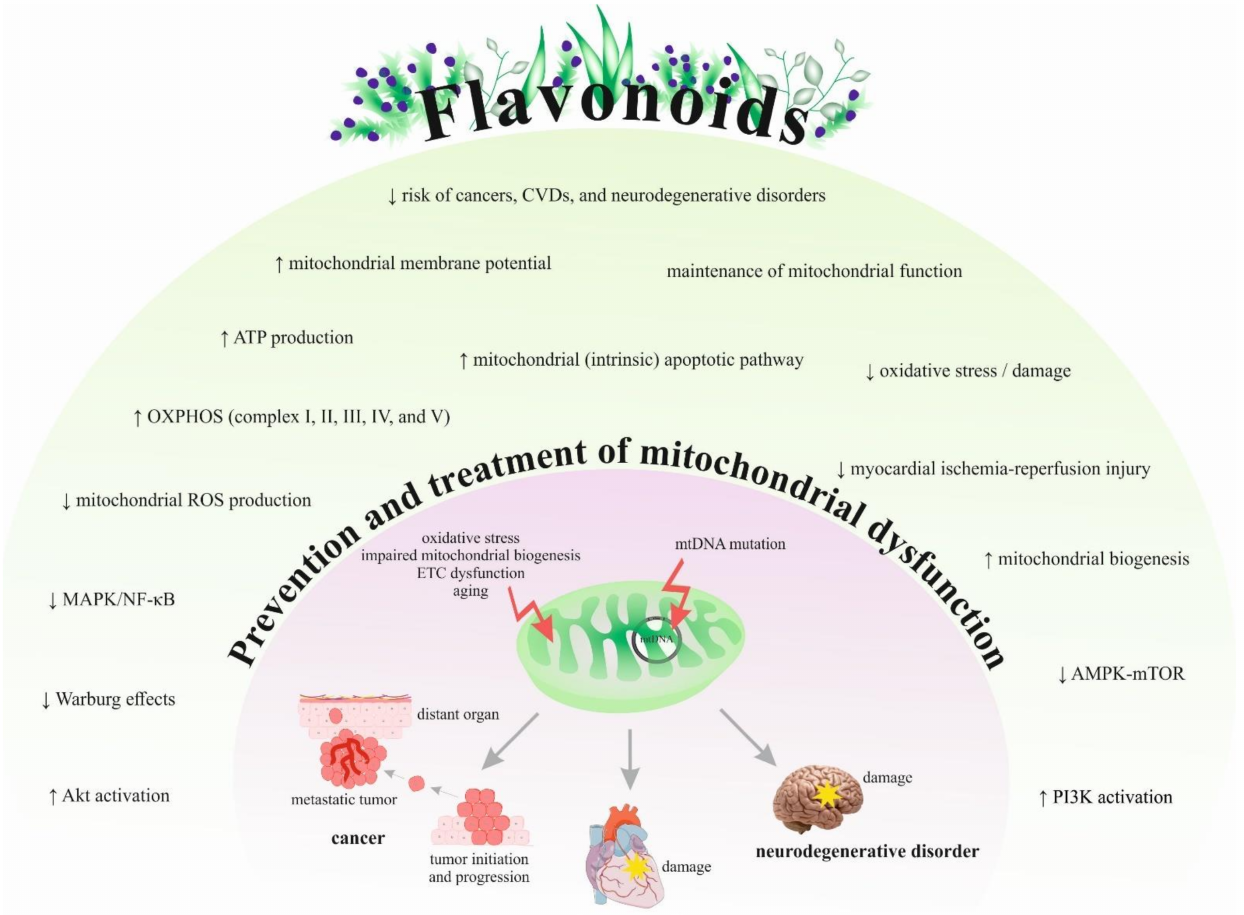
Figure 3. The mechanisms of flavonoids in the prevention and treatment of mitochondriopathies. Abbreviations: EGCG, epigallocatechin-3-gallate; EGb 761 ® , Ginkgo biloba extract; CVDs, cardiovascular diseases; mtDNA, mitochondrial DNA; OXPHOS, oxidative phosphorylation; ROS, reactive oxygen species; ↑ , increase/induce; ↓ , decrease/reduce; ETC, electron transport